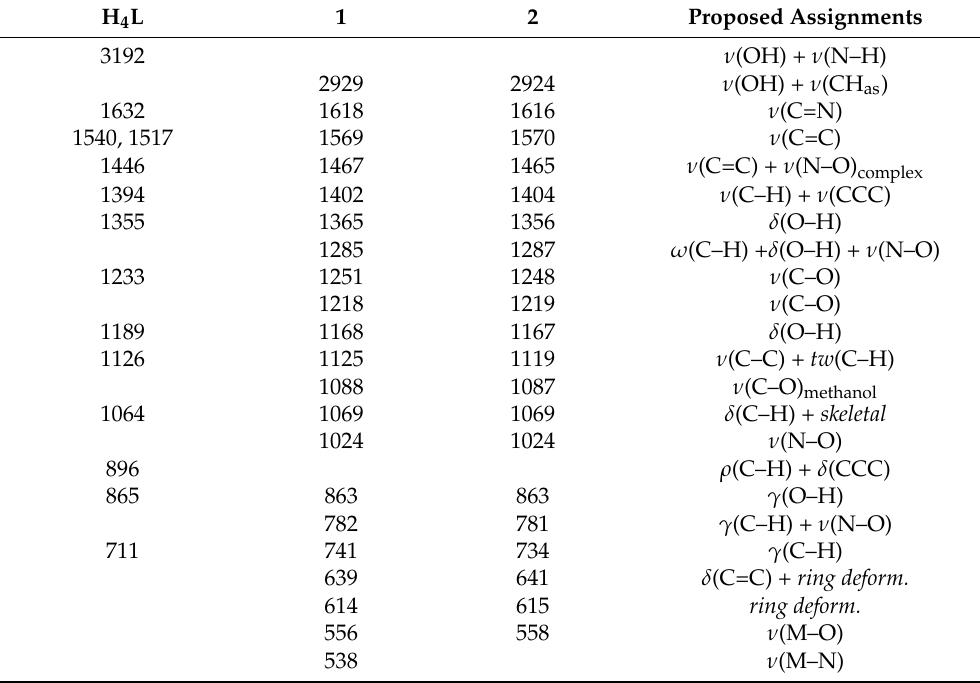
Table 2. The selected frequencies (cm − 1 ) of absorption bands in FTIR spectra of Schiff base ( H 4 L ), Cu II –Ho III –Cu II 1 and Cu II –Er III –Cu II 2 . H 4